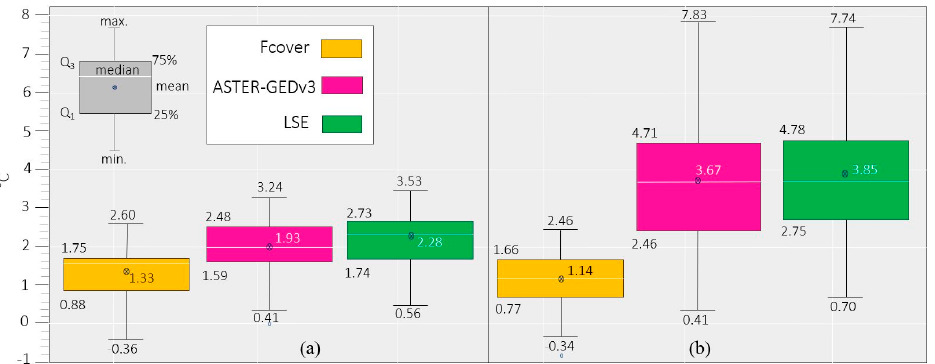
Figure 7. Boxplots of LST results from Fcover, ASTER-GEDv3, and LSE. The white horizontal line in each box is the median. ( a ) January 2019; ( b ) September 2019.